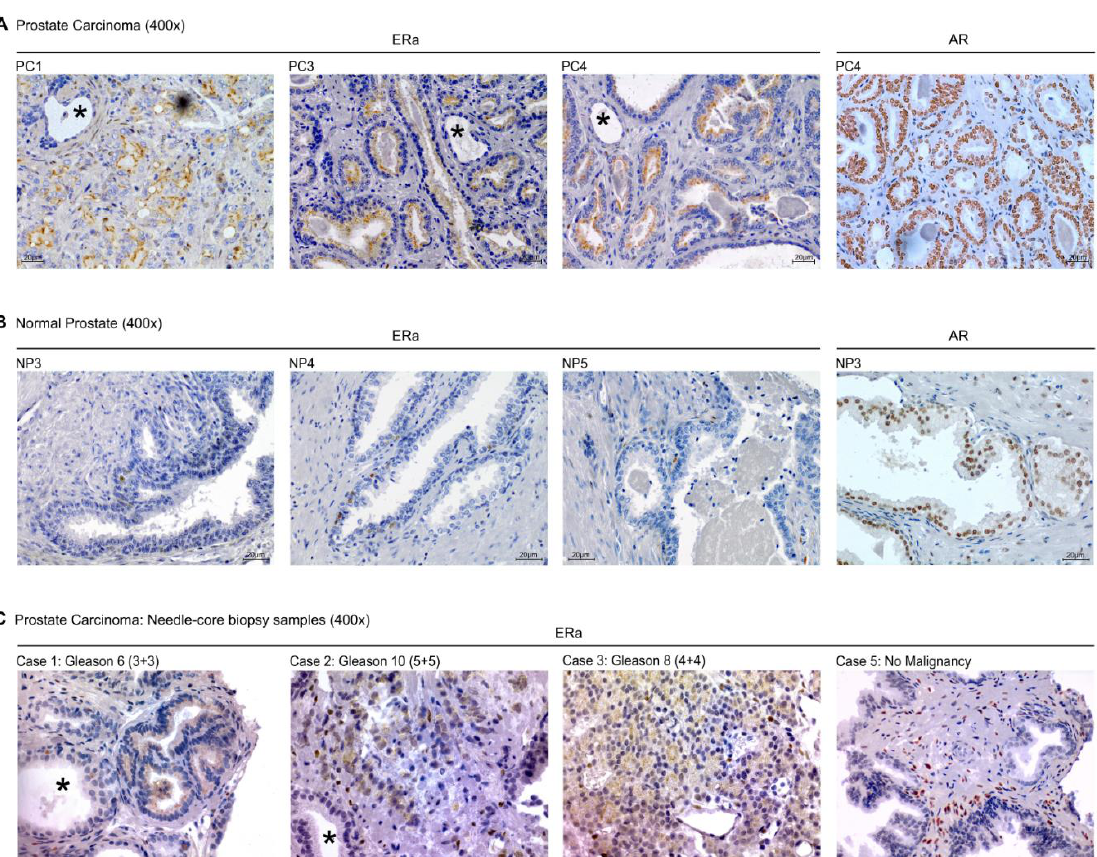
Figure 7. Immunohistochemistry with ColNu mIHCF conditions confirms ERa as a marker of prostate cancer. ( A ) Representative microphotographs of prostate cancers from TMA-I and II performed with overnight incubation of the primary antibody ( ColNu mIHCF conditions). Left: Cancer epithelium is positive for ERa at the apical membrane, while normal prostate epithelium is not. Right: Nuclei of cancer and normal epithelial cells are positive for AR. ( B ) Left: Normal prostate epithelium is negative for ERa. At the basal layer, isolated cells show positivity for ERa. Right: Prostate epithelial cells in normal tissue express nuclear AR. ( C ) Sections from prostate needle-core biopsies similarly stained for ERa showing the stained prostate cancer while the normal tissue (asterisk) is negative or presents isolated nuclear ERa positive cells at the basal layer. Right: a case with no malignancy exhibits a proliferation of ERa cells within the stroma. (*, asterisks indicate normal prostate epithelium).